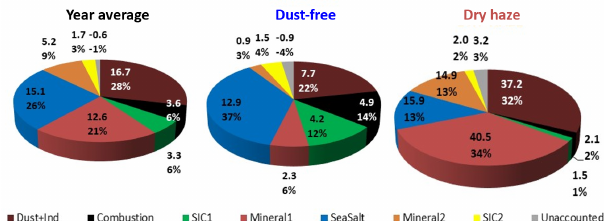
Figure 6. PMF source apportionment results for the total campaign and during the two pollution seasons. Values are in µgm − 3 and percentage of measured total